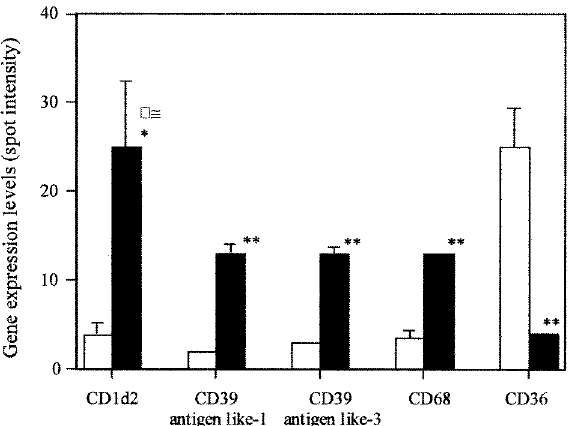
FIG. 1. The mRNA expression levels for cell surface antigen in the lung and trachea tissue of influenza-infected mice. Results are presented as the mean ± SE from three independ- ent experiments. Open column, before infection; filled column, 48-h after infection of influenza virus. * p < 0.05 ** p < 0.01 compared with non-infected controls, analyzed by Student’s t